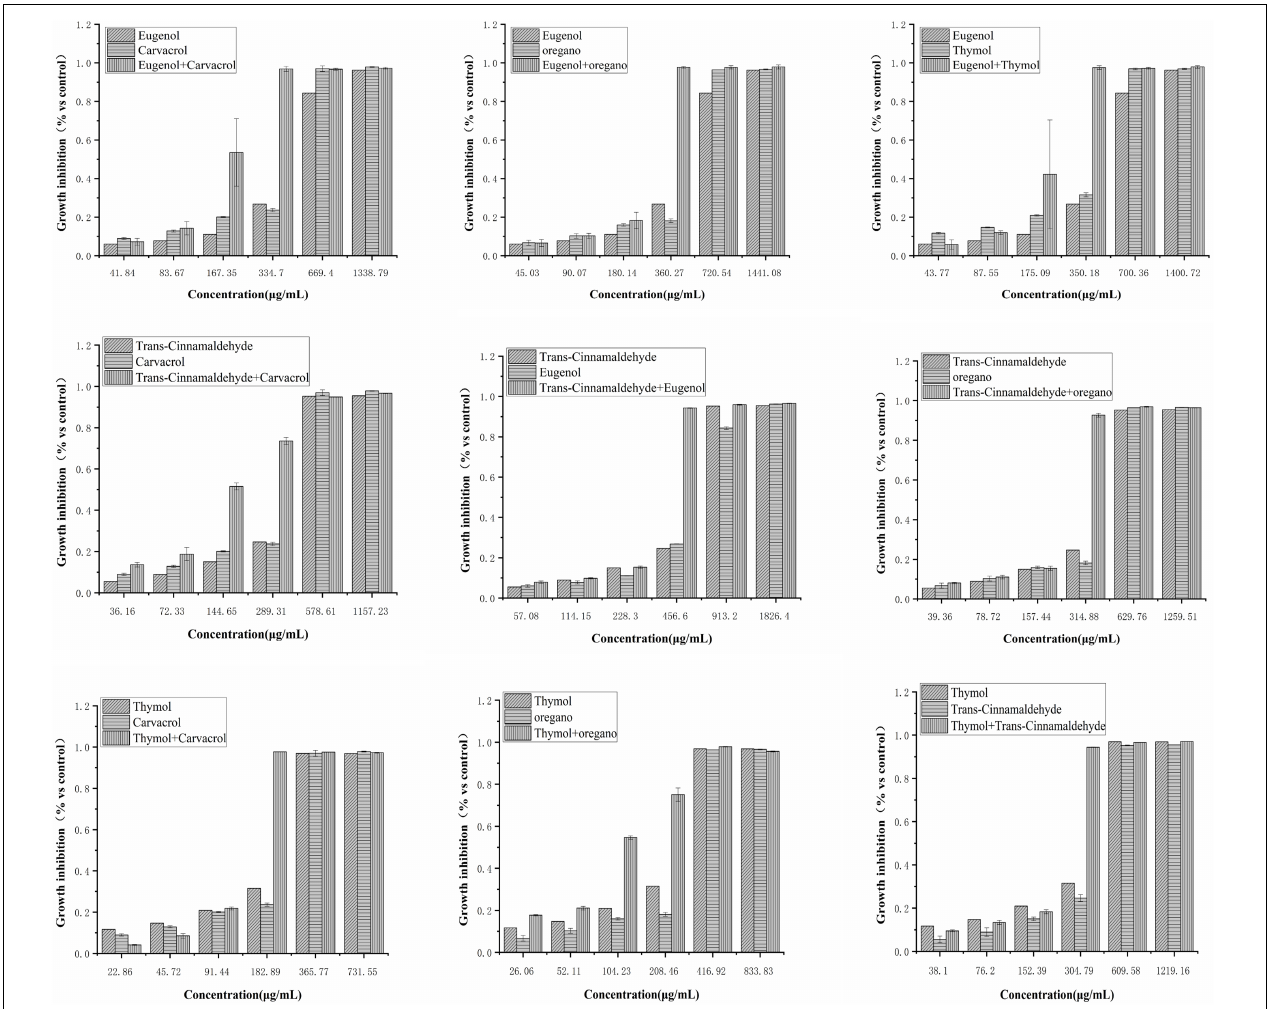
FIGURE 2 | Effect of single and combined of natural antimicrobials on the growth inhibition rate of Klebsiella pneumoniae BNCC